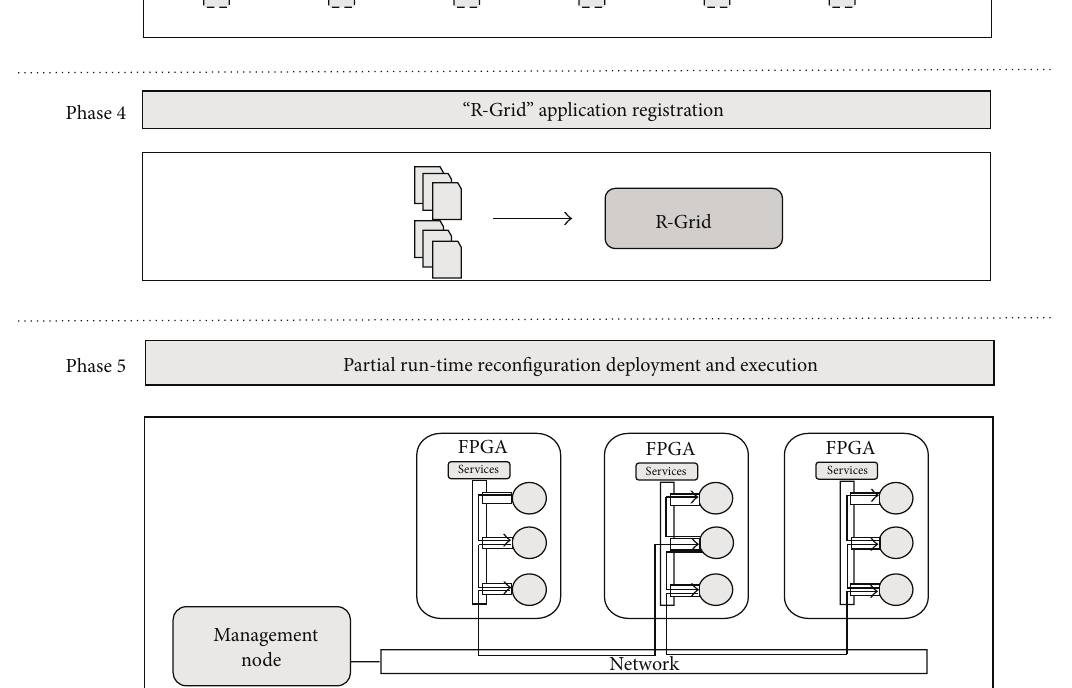
Figure 7: Application development